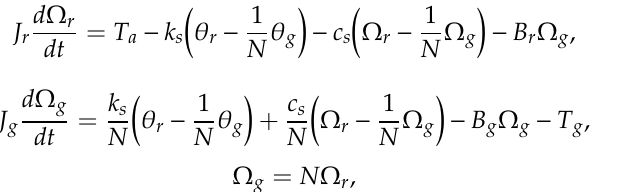
Figure 6. The block diagram of the wind turbine model.